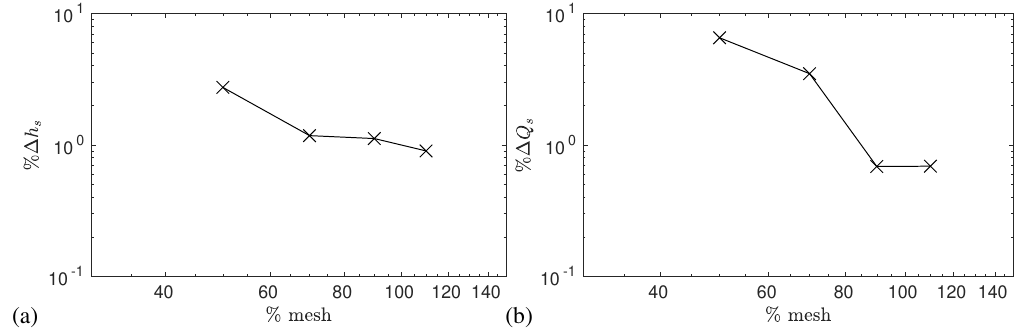
Figure 6. Convergence plots, where ( a ) percent height error % ∆ h s and ( b ) percent volumetric flow rate error % ∆ Q s are compared against the ICF-1 analytic study as functions of the reported percent mesh count. Values time-averaged for the first 15 s of draining.